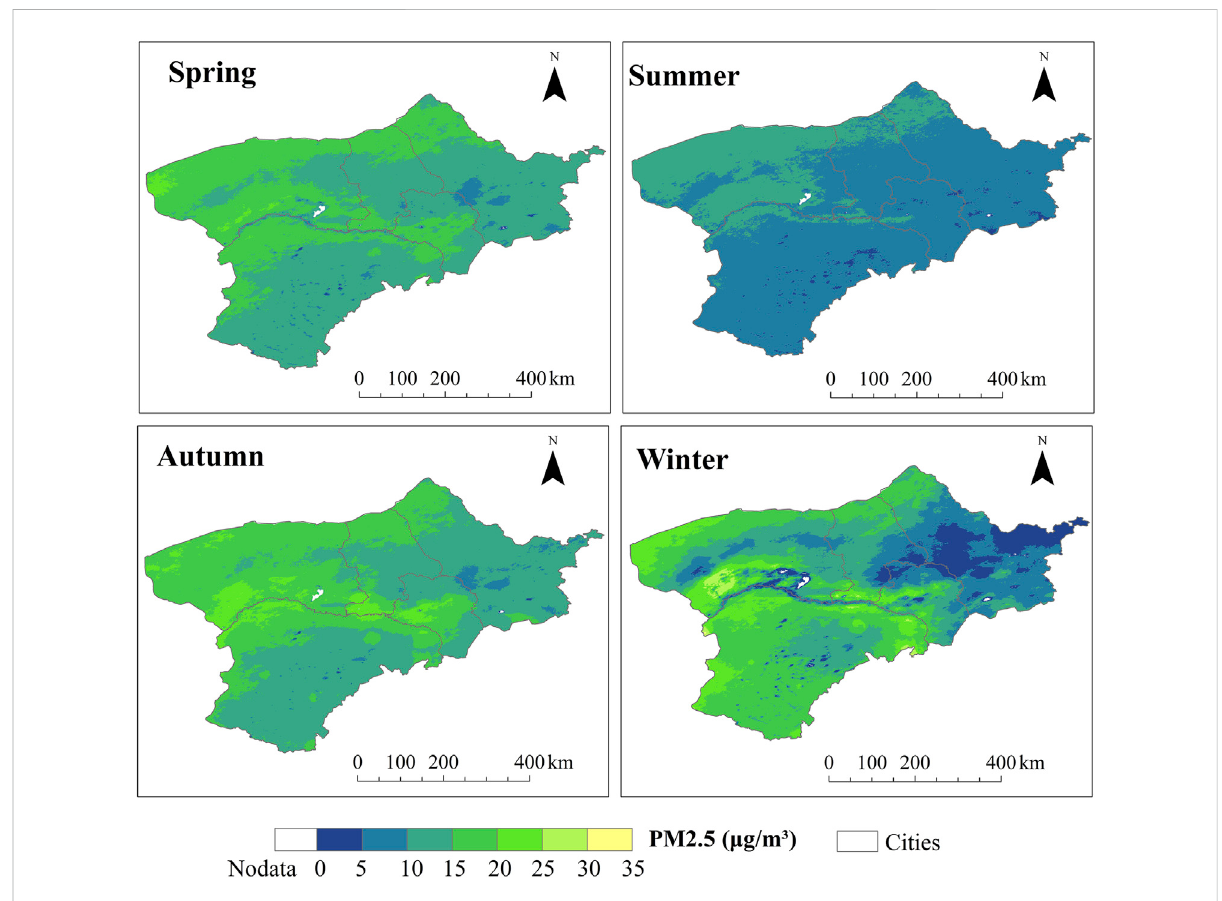
FIGURE 6 Spatial distribution of seasonal average PM2.5 concentration from 2016 to